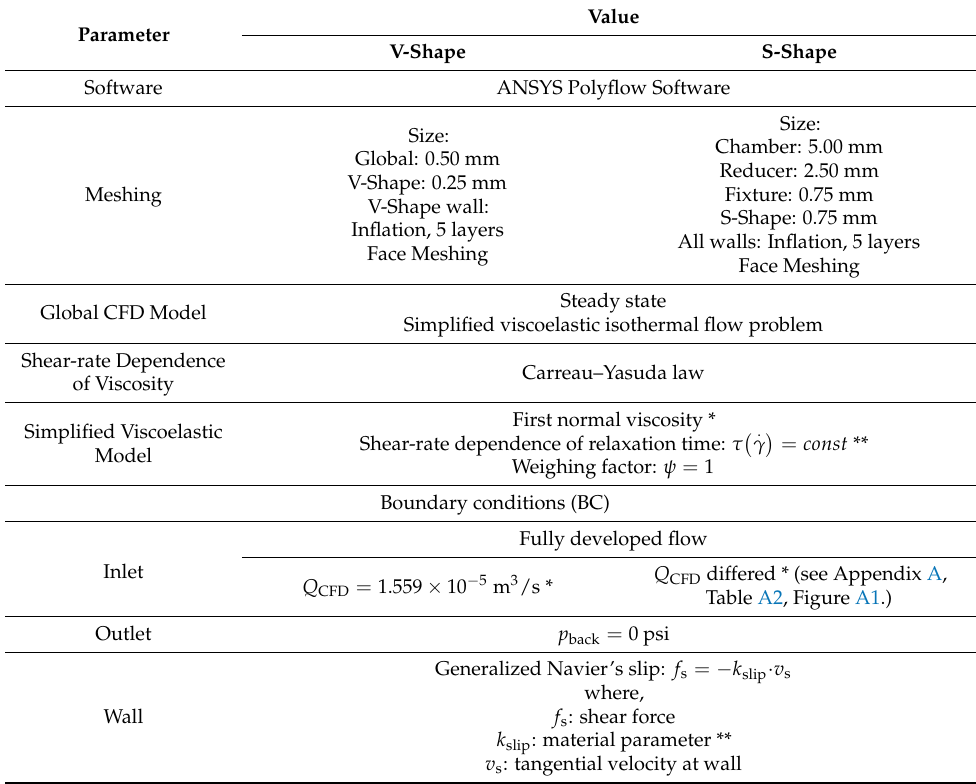
Table 1. CFD setups: V-shape and S-shape